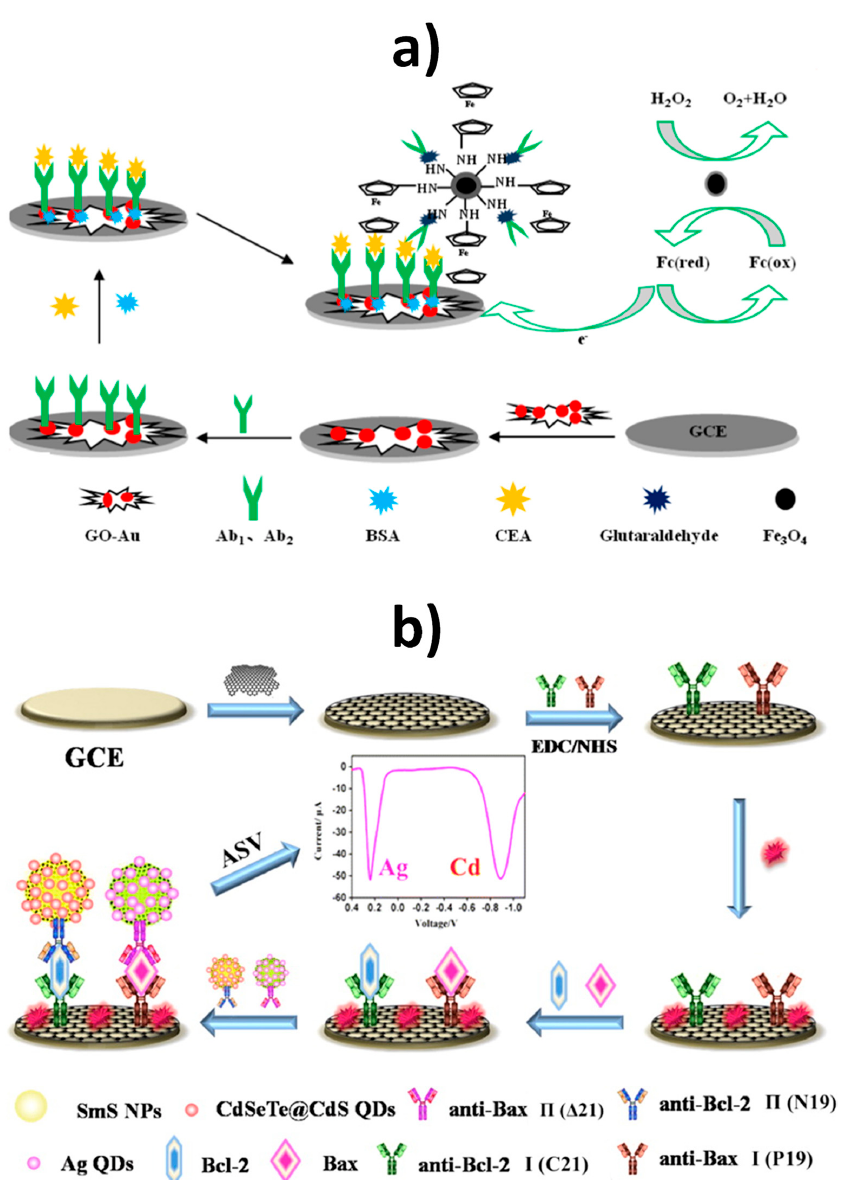
Figure 16. Sandwich electrochemical immunosensors developed for: ( a ) the determination of CEA using Fe 3 O 4 @SiO 2 –Fc–DAb/HRP nanobioconjugates and ( b ) the simultaneous determination of Bcl-2 and Bax using mesoporous SiO 2 decorated with DAb and CdSeTe@CdS quantum dots (QDs) or Ag nanoclusters (NCs). Reprinted and adapted from [182] ( a ) and [180] ( b ) with